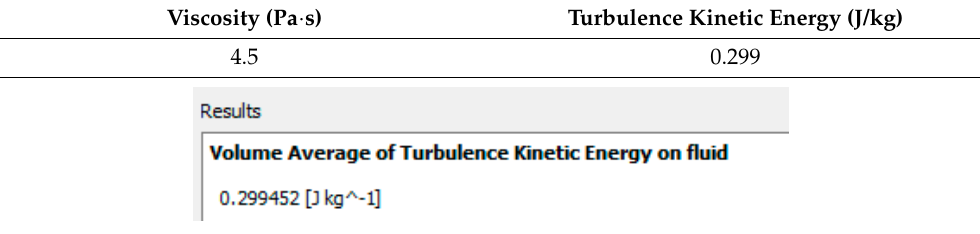
Table 3. Result of turbulence kinetic energy when viscosity is 4.5 Pa · s.